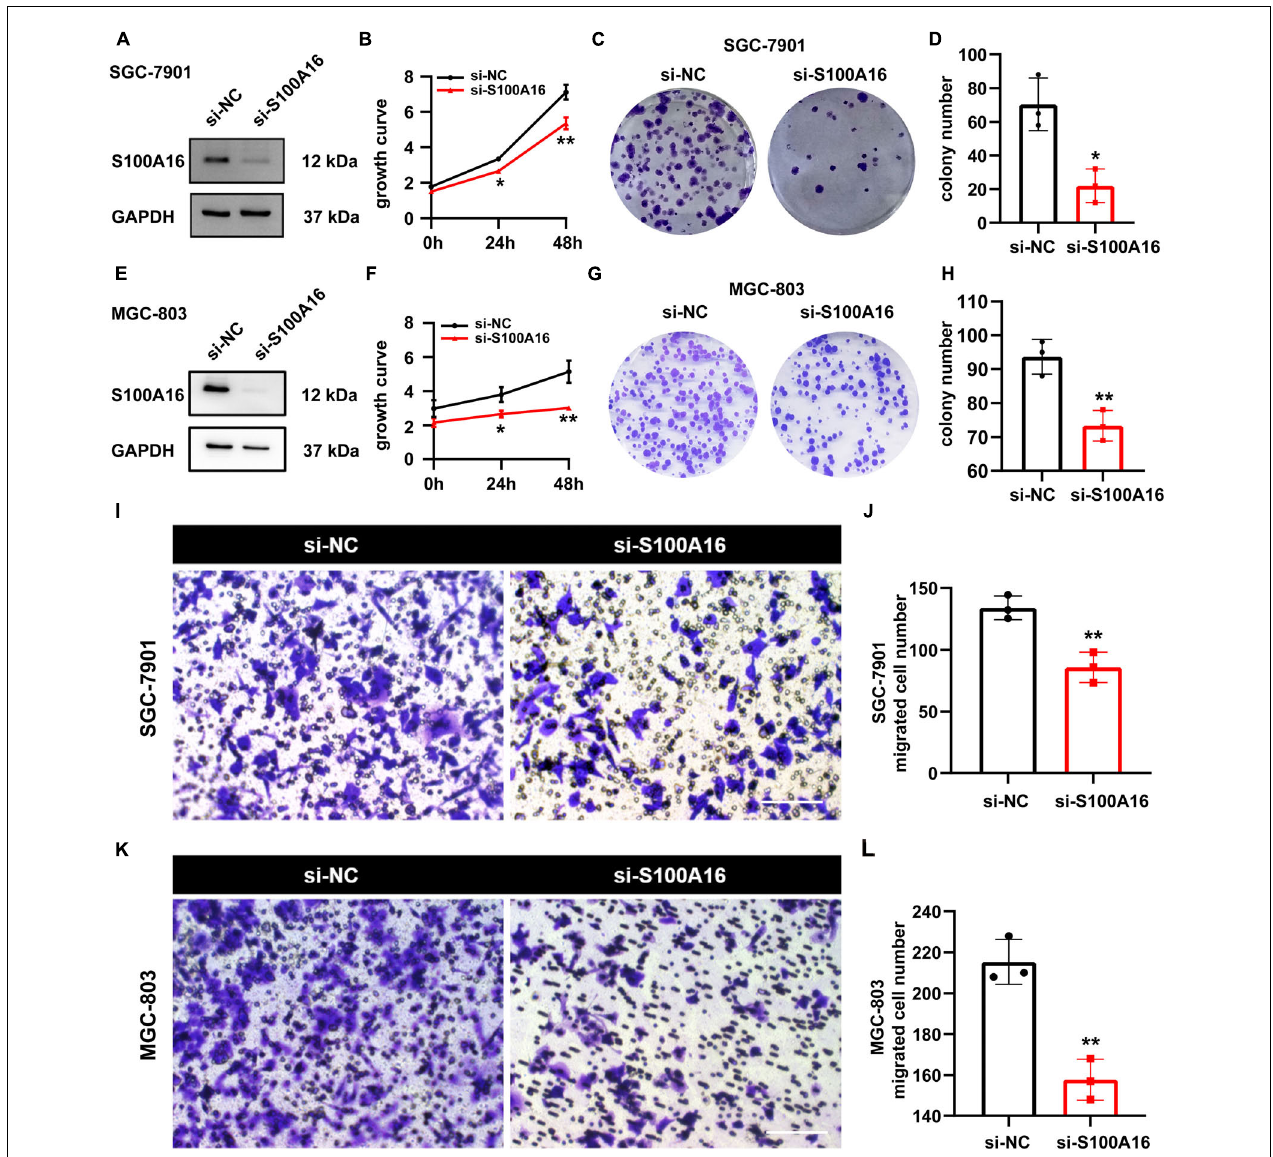
FIGURE 5 | S100A16 inhibition suppresses GC cells growth and migration. (A) S100A16 knockdown in SGC-7901 cells were confirmed by Western Blotting. (B) Cell growth was measured by SRB staining in SGC-7901 cells transfected with si-NC and si-S100A16. (C) Colonies formed by SGC-7901 cells in panel (B) . (D) Colonies number in panel (C) were quantified. (E) S100A16 knockdown in MGC-803 cells were confirmed by Western Blotting. (F) Cell growth was measured by SRB staining in MGC-803 cells transfected with si-NC and si-S100A16. (G) Colonies formed by MGC-803 cells in panel (F) . (H) Colonies number in panel (G) were quantified. (I,J) The migration ability of SGC-7901 cells transfected with si-NC and si-S100A16 was measured by transwell assay. Migrated cell numbers were counted in panel (J) . Scare bar = 100 µ m. (K,L) The migration ability of MGC-803 cells transfected with si-NC and si-S100A16 was measured by transwell assay. Migrated cell numbers were counted in panel (L) . Scare bar = 100 µ m. Data are presented as mean ± SD. N = 3 for each group. For panels (B,D,F,H,J,L) , * P < 0.05 and ** P < 0.01 vs. si-NC